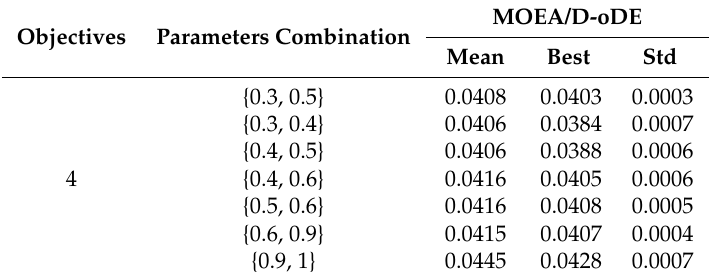
Table 8. IGD metric value statistics for F1 with 4 objectives on different